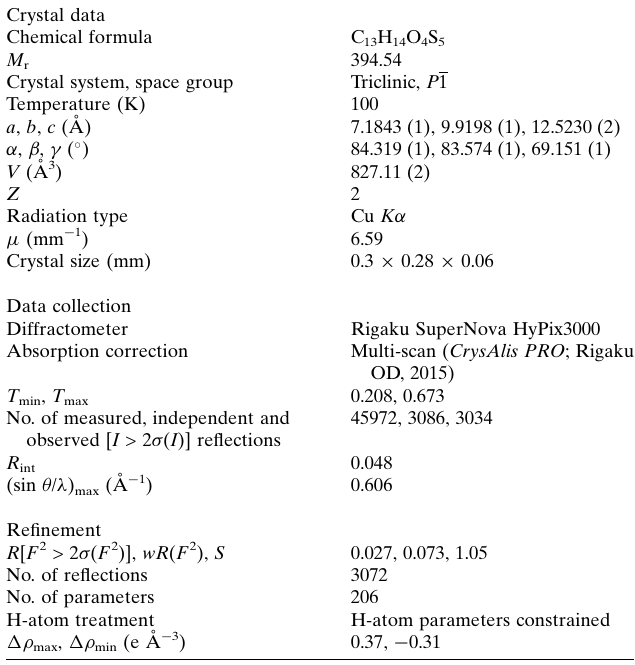
Table 3 Experimental details. Crystal data Chemical formula